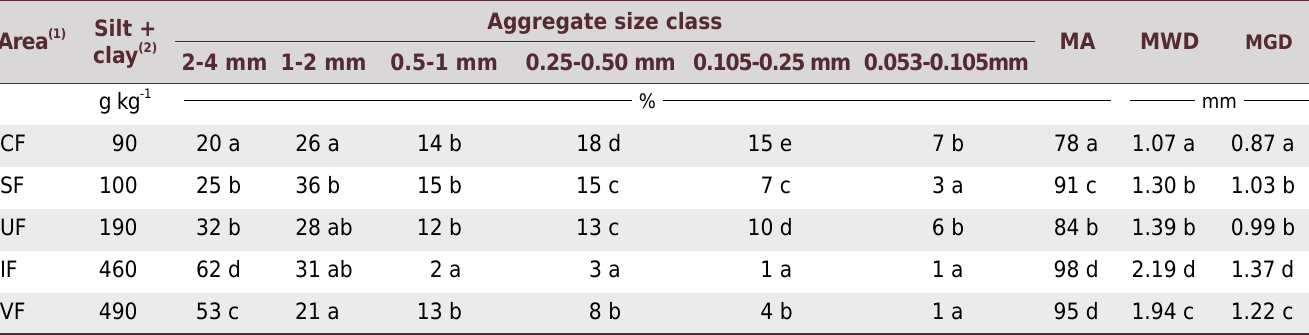
Table 6. Average values of percentage of mass by aggregate classes of soils of different areas from Brazilian East Coast, 0.00-0.08 m soil layer Silt + Area (1) clay